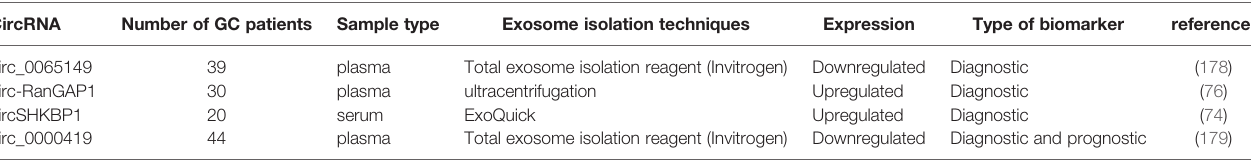
TABLE 4 | The potential biomarker of exosomal circRNA in GC. CircRNA Number of GC patients Sample